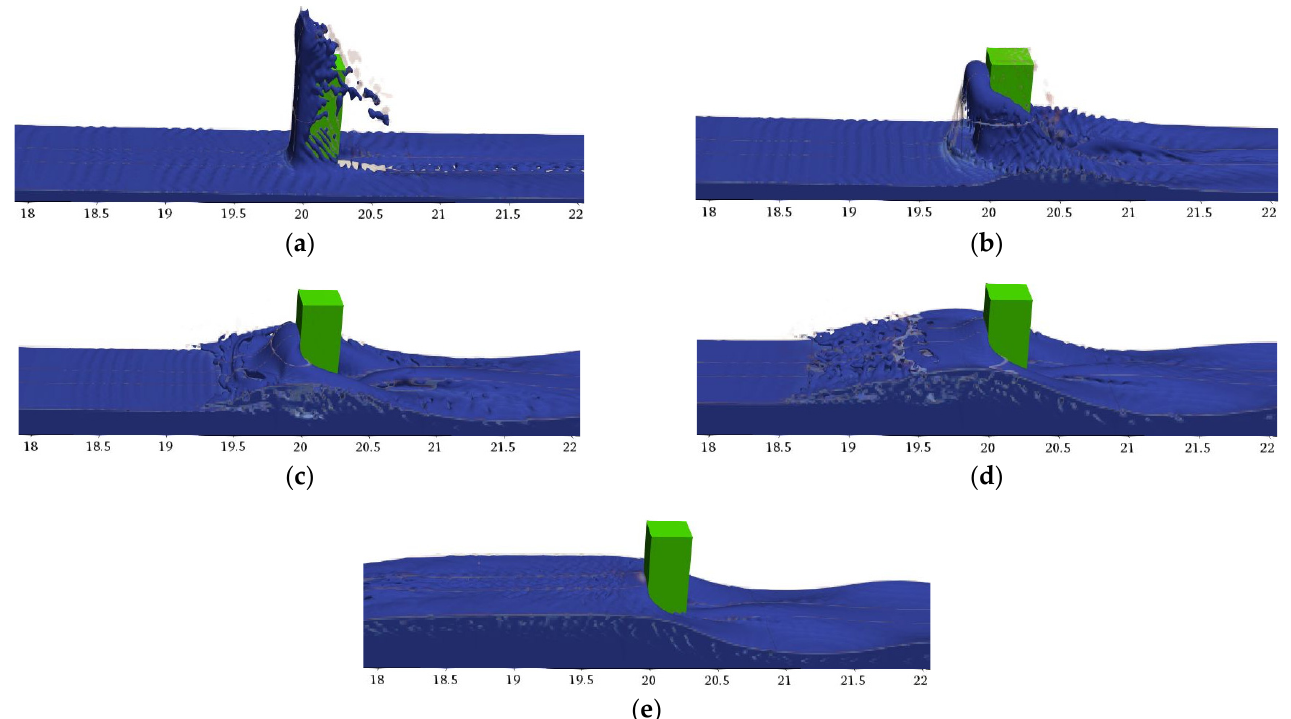
Figure 7. Surge interaction process in the absence of a mitigation wall. The numbers in the images represent the distance in the x-direction from the tank origin in meters: ( a ) impact phase ( t ( g/d o ) 0.5 = 9.57); ( b ) initial reflection phase ( t ( g/d o ) 0.5 = 12.05); ( c ) transition phase ( t ( g/d o ) 0.5 = 18.48); time of F n,max ; ( d ) near-hydrostatic transition phase ( t ( g/d o ) 0.5 = 25.08); time of M n,max ; ( e ) choked quasi-steady phase ( t ( g/d o ) 0.5 = 35.0).